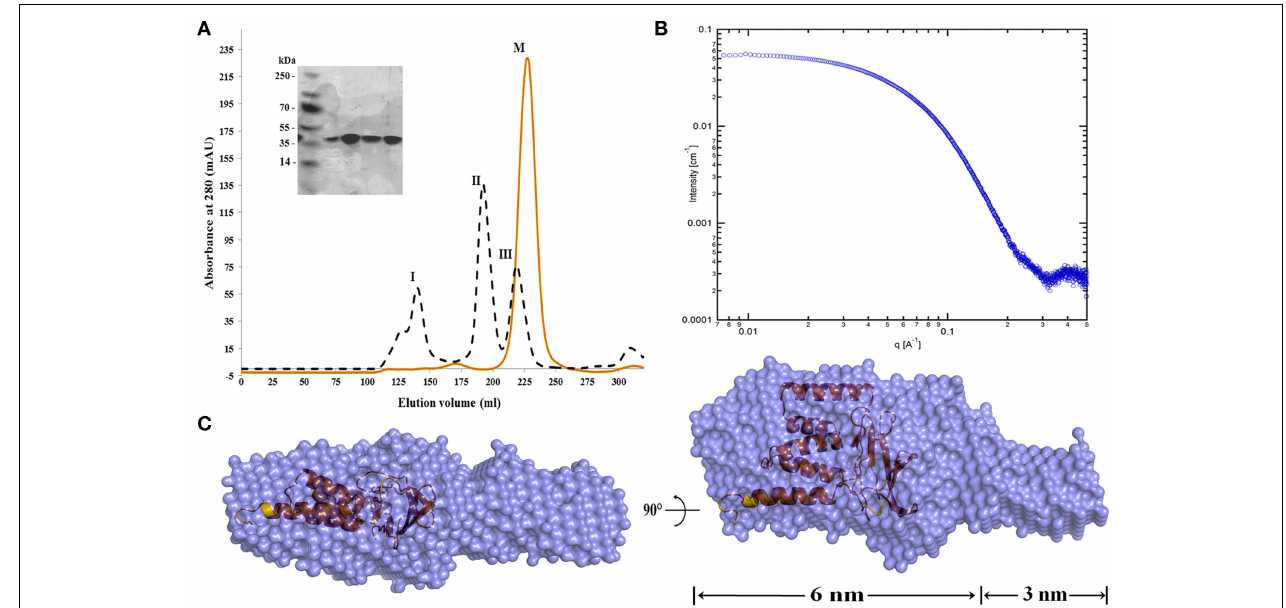
FIGURE 2 | MtxA 1 1 − 24 size-exclusion chromatography and SAXS envelope model. (A) Size exclusion (Superdex 200 HiLoad 26/60) chromatography analysis of the MtxA 1 1 − 24 (red) and chromatographic separation and calibration curve for the standard proteins (black). The standard proteins are: I: Thyroglobulin (Mr = 669,000), II: Aldolase (Mr = 158,000) and III: Ovalbumin (Mr = 44,000) (Gel Filtration Calibration Kit